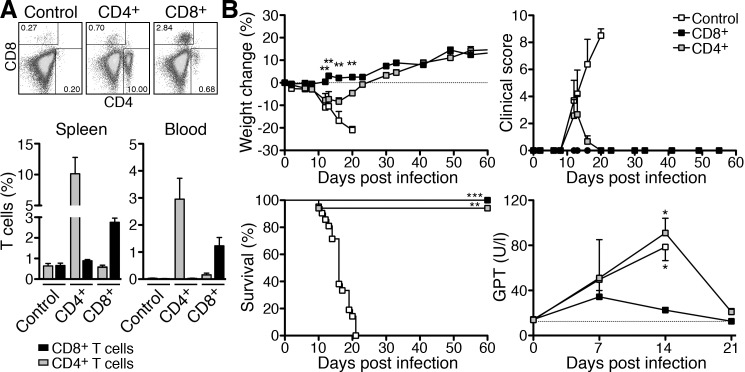
Adoptive transfer of either CD8+ or CD4+ T cells protects CB17 SCID mice from severe disease and death.CD4+ and CD8+ T cells were isolated from naïve BALB/c mice. 1×106 T cells were adoptively transferred into CB17 SCID mice 1 day prior to infection with 1×106 sfu R. typhi or treatment with PBS (Control). Spleen and blood of the animals were analyzed for the presence of T cells on day 7 post infection. The dot plots show example stainings of spleen cells for CD4 and CD8 from a CB17 SCID control mouse, a CD4+ T cell recipient (middle) and a CD8+ T cell recipient (right). The graphs show the statistical analysis of the spleen (left) and blood (right). The percentage (y-axis) of CD4+ and CD8+ T cells (x-axis) was determined for control mice (n = 5; white bars), CD4+ T cell recipients (n = 5; gray bars) and CD8+ T cell recipients (n = 5; black bars). On average CD4+ T cell recipients contained 10.1±2.6% CD4+ T cells while CD8+ T cells were virtually absent (0.9±0.1%). 2.8±0.2% CD8+ T cells were detected in CD8+ T cells while CD4+ T cells were absent (0.6±0.1%). The percentage of T cells in the blood was lower (3.0±0.8% CD4+ T cells in CD4+ T cell recipient and 1.2±0.3% CD8+ T cells in CD8+ recipients) (A). Weight change (n = 5 for control animals and n = 6 for T cell recipient groups), clinical score (n = 5 for control animals and n = 6 for T cell recipient groups), survival (n = 11 for each group) and serum GPT levels (n = 3–5 for each group) were assessed (y-axis) at indicated points in time (x-axis). Differences in the weight change between CD4+ and CD8+ T cell recipients were compared by Mann-Whitney U test at indicated points in time. Statistical analysis of GPT levels was performed by One-way ANOVA (Kruskal Wallis test followed by Dunn´s post) test. Asterisks indicate significant differences compared to day 0 (*p<0.05, **p<0.01). The survival graph shows combined results from 2 independent experiments. Statistical analysis was performed with Log-rank (Mantel-Cox) test. Asterisks indicate significant differences compared to control animals (**p<0.01, ***p<0.001) (B).